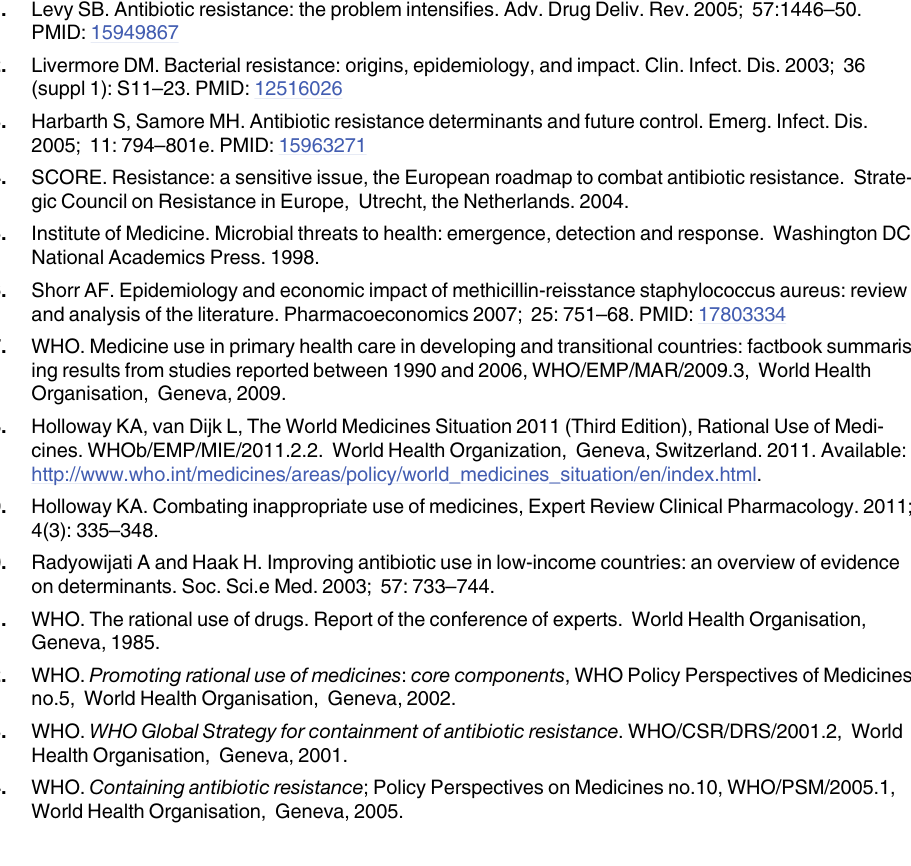
S1 Table. Reported antibiotic policy implementation by country. S2 Table. Individual antibiotic use measures by country plus